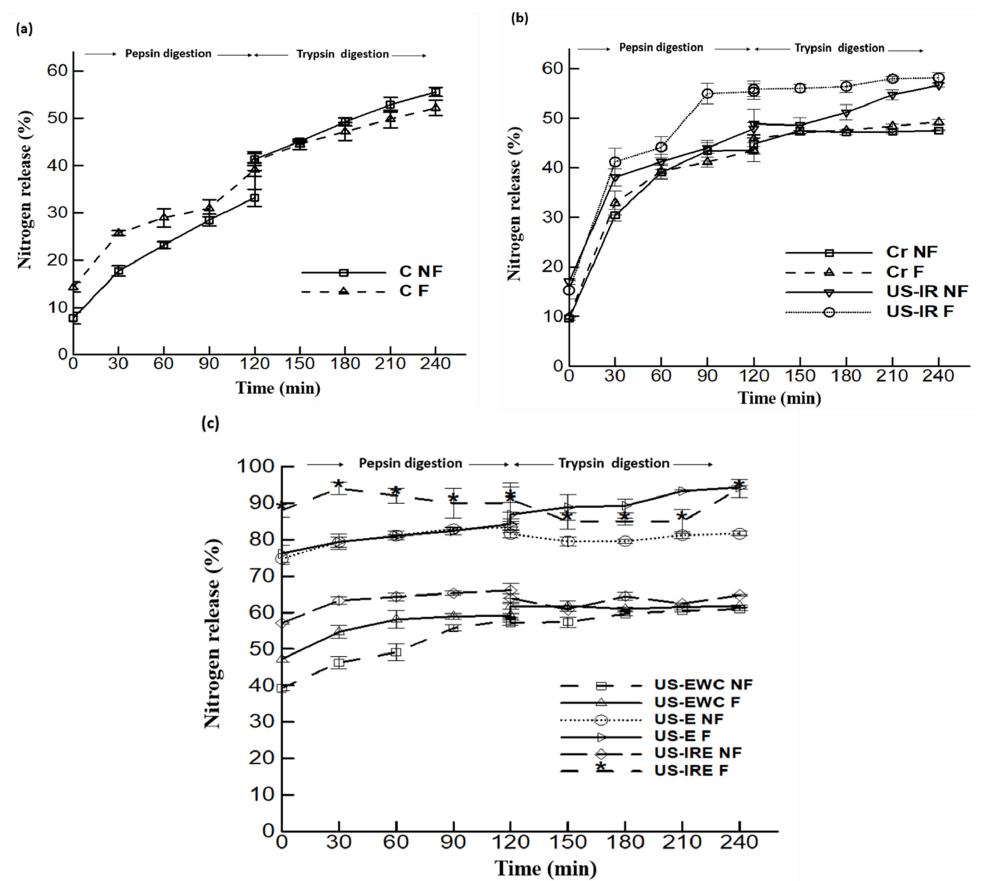
Figure 4. Percentage of nitrogen released from fermented (F) and non-fermented (NF) non-enriched (control C) ( a ), untreated cricket protein-enriched (Cr) beverages, treated with γ -irradiation assisted with ultrasound (US-IR) ( b ), and treated cricket protein-enriched beverages subjected to enzymatic hydrolysis assisted with ultrasound (US-E), to enzymatic hydrolysis assisted with ultrasound the whole product of hydrolysis (US-EWC), to enzymatic hydrolysis assisted with γ -irradiation and ultrasound (US-IRE) ( c ) during pepsin (120 min) and trypsin (120 min) simulated digestion. Data shown is the mean ± SD, n = 3.